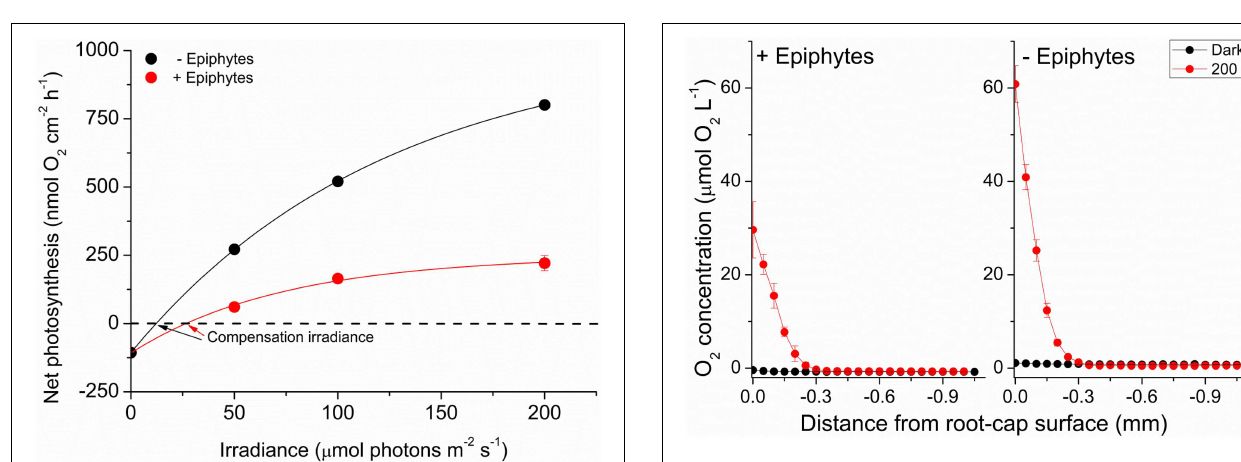
(-) indicate no data points. Negative values denote net O 2 uptake. Rates are mean ± S.D. n = 3–5; leaf/root level replicates. a , b Indicates significant difference between seagrasses with leaf epiphyte cover as compared to seagrasses without leaf epiphyte cover (control plants) ( a Two-Way ANOVA, F 3,3 ( PAR ) =